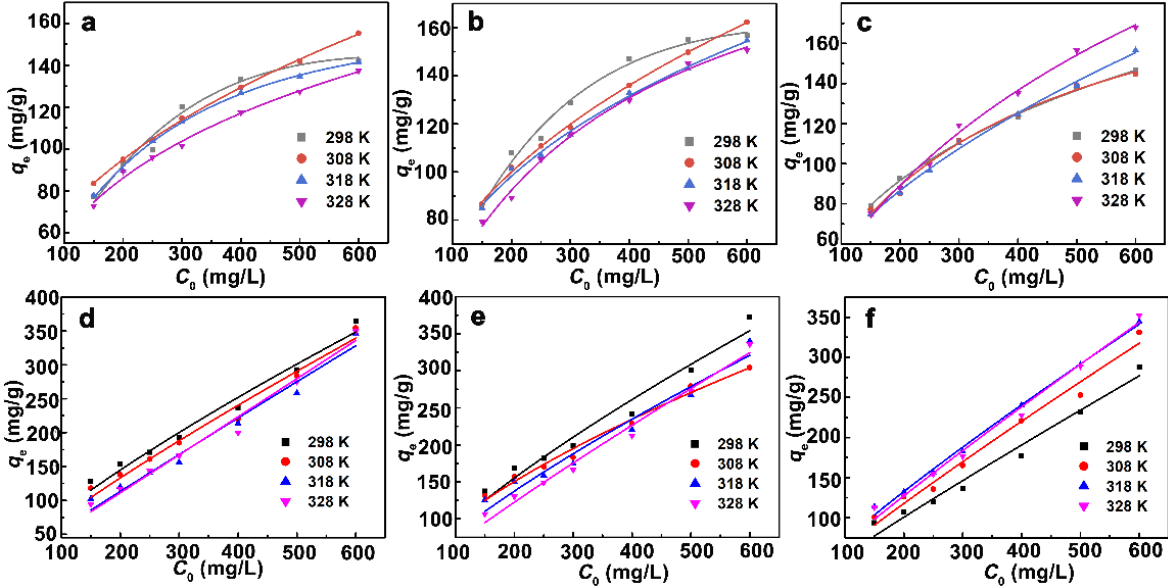
Figure 6. The effects of adsorbate concentration and temperature on the adsorption of 2-NP ( a – c ) and BPB ( d – f ).